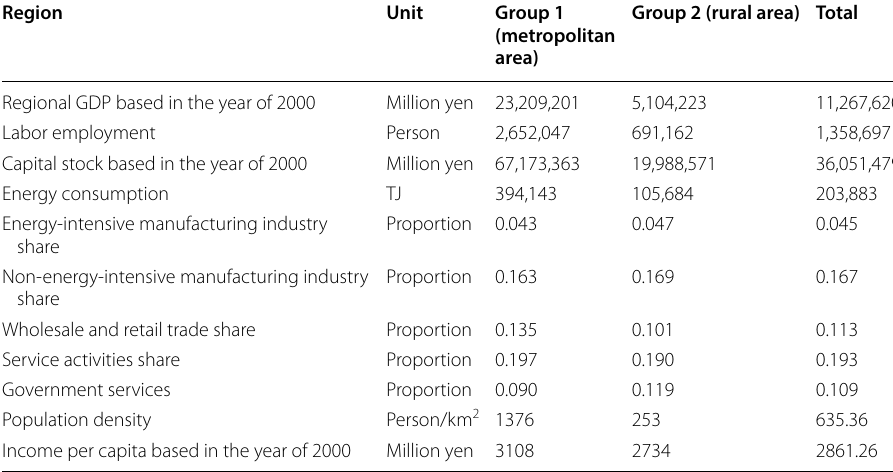
Table 1 Characteristics of each group